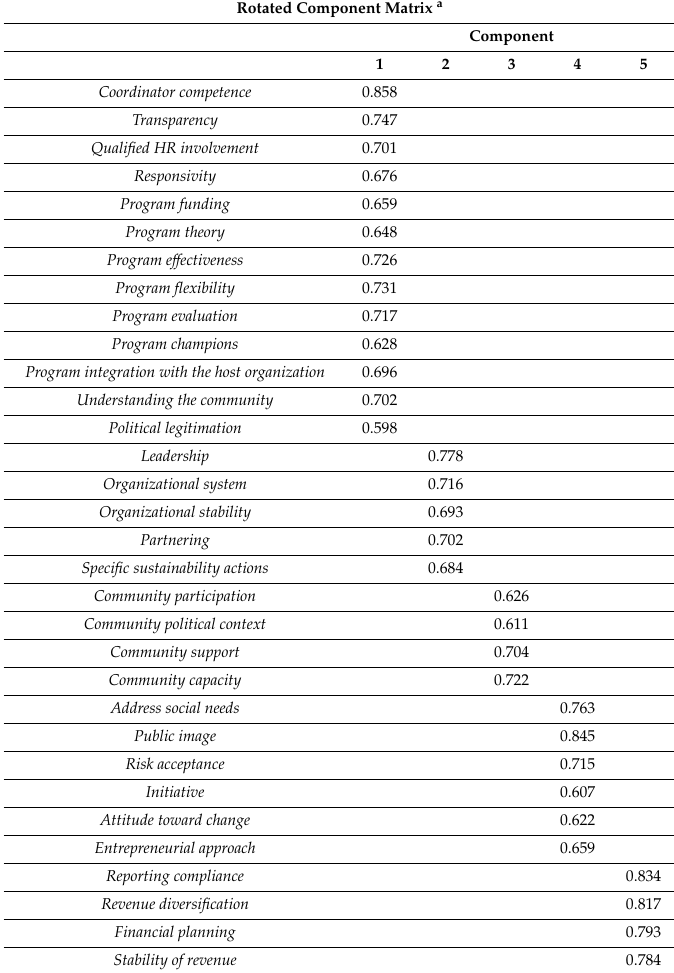
Table 7. Rotated component